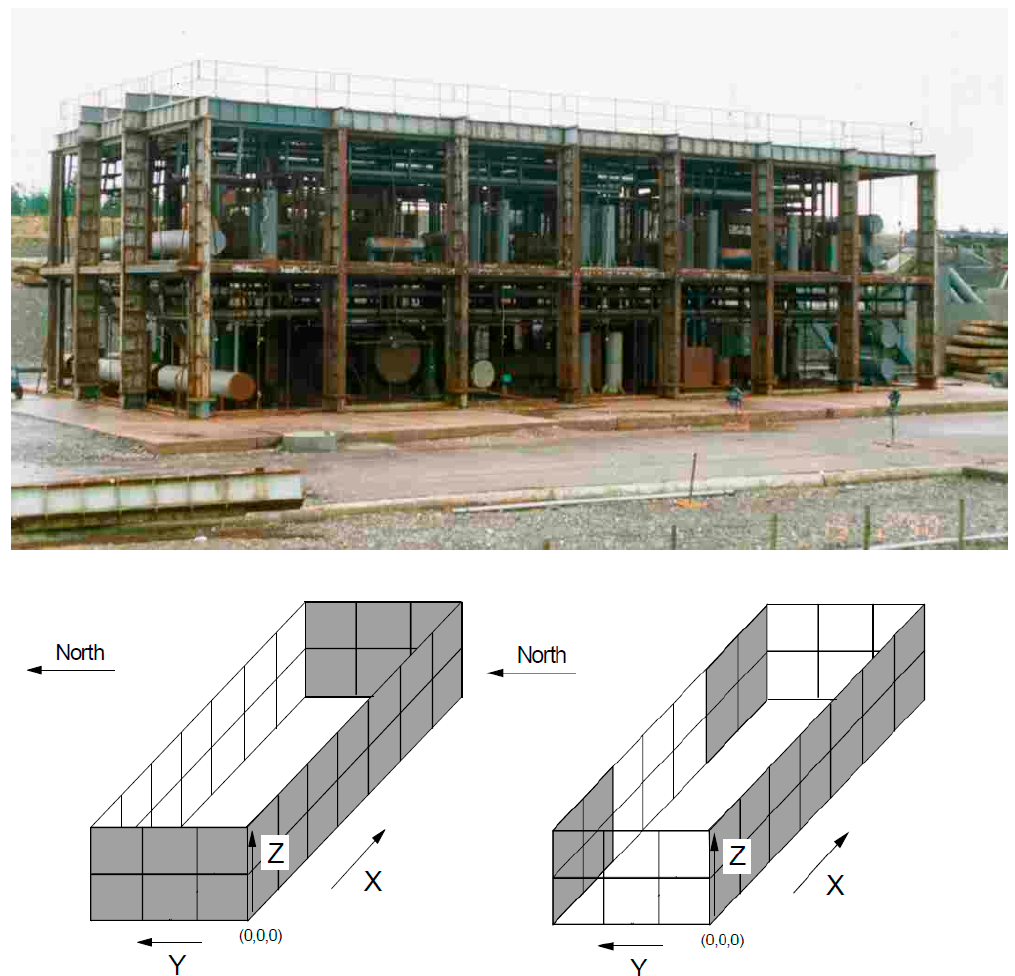
Figure 3. A picture of the Phase 3B test rig. It measures about 28 m long, 12 m wide and 8 m high and was a large-scale model of a process module on an offshore platform. Schematic diagrams showing the two wall layouts or configurations (these layouts are given names “C2” on the left, and “C1” on the right). The direction north points out of the